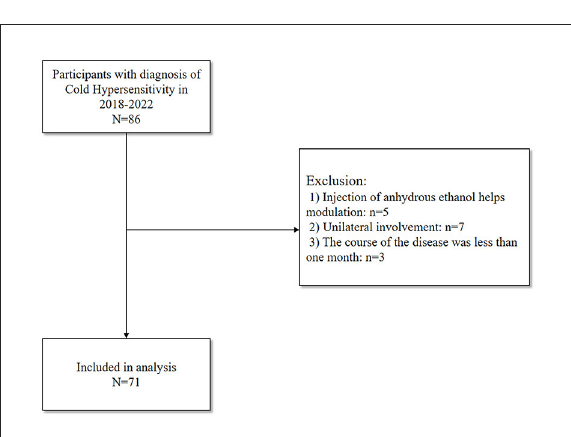
FIGURE3 Flowchart depicting the detailed process of patients’ enrollment.